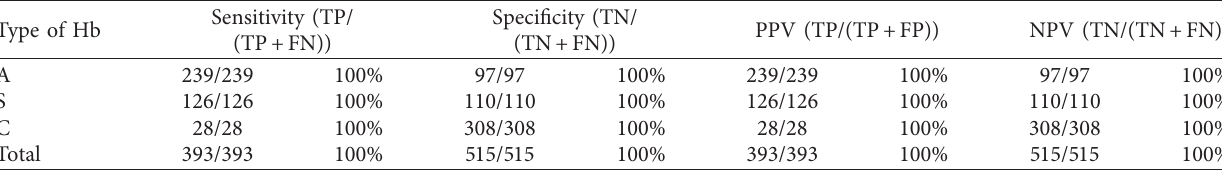
Table 4: Analysis of the sensitivity and specificity of the HemoTypeSC ™ test for the detection of hemoglobin A, S, and C.